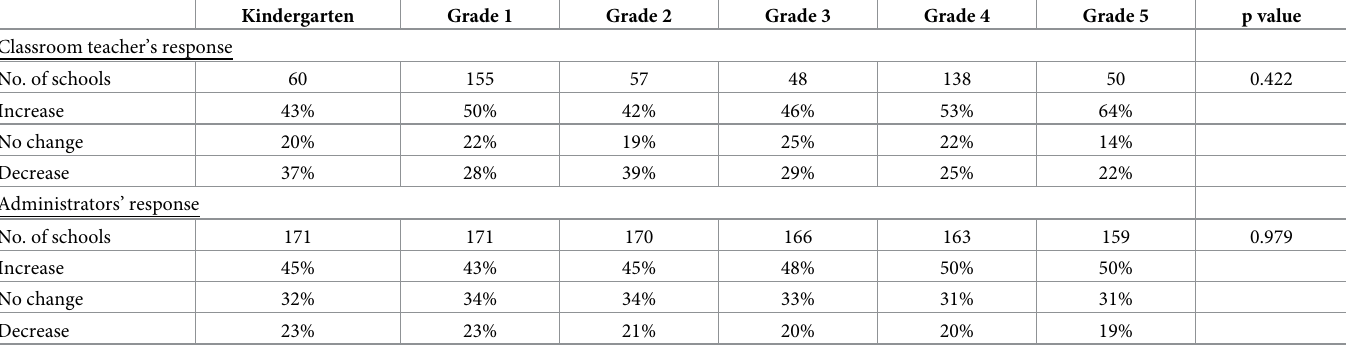
Table 2. Proportion of schools (by grade) with increase, decrease, or no change in total physical activity time by at least 5 minutes per day from 1 st to 2 nd wave of data